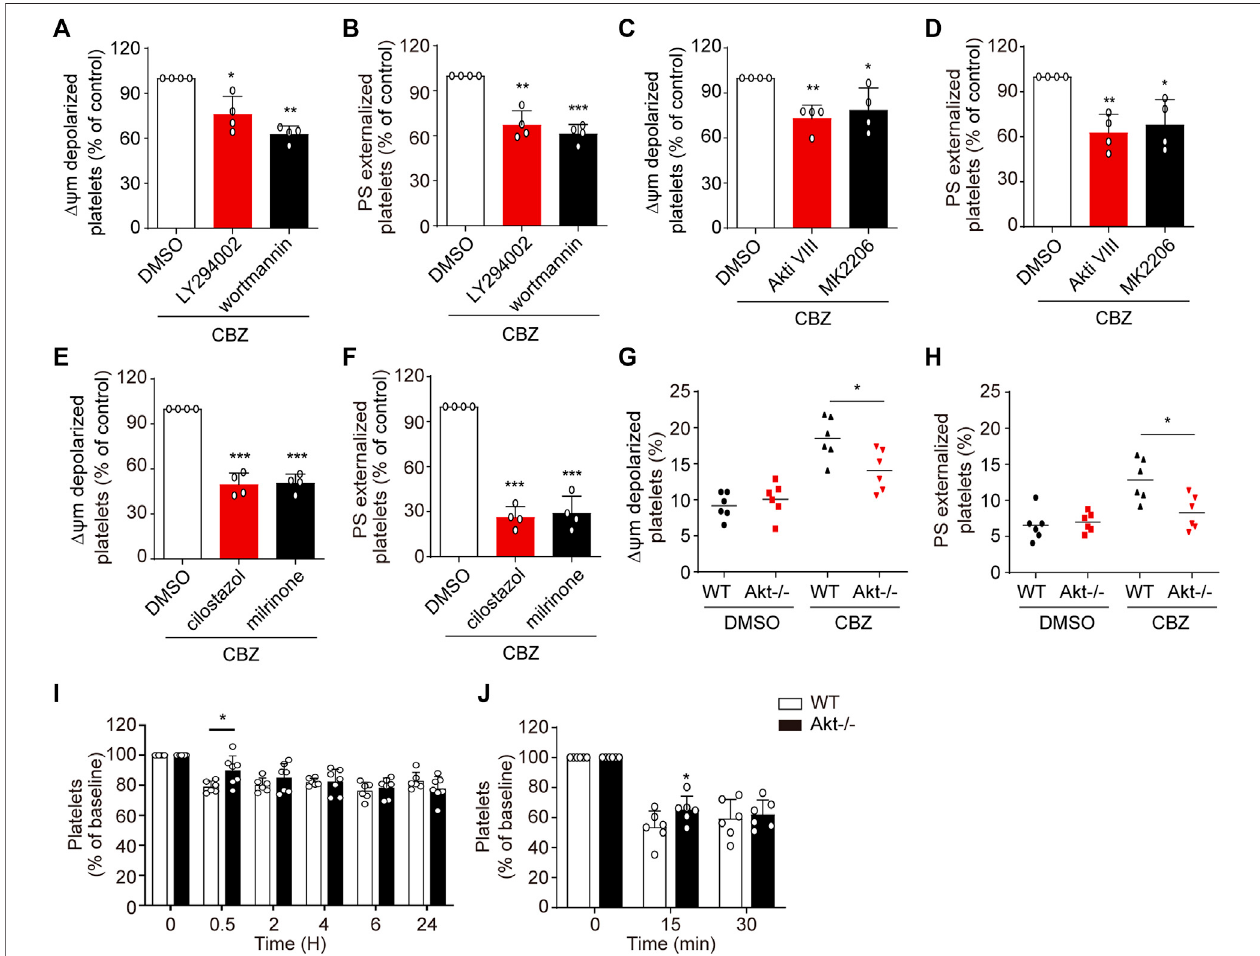
FIGURE 5 | PI3K/Akt/PDE3A inhibition rescues CBZ-treated platelets from apoptosis. (A – F) Washed human platelets were pretreated with indicated concentrations of inhibitors at 37 ° C for 10 min and then incubated with 100 μ M CBZ at 37 ° C for 70 H. (A,B) Flow cytometric analysis of Δψ m depolarization (A) and PS externalization (B) inplateletsinresponsetoPI3Kinhibitors. (C,D) Flowcytometricanalysisof Δψ m depolarization (C) andPSexternalization (D) inplateletsinresponseto Aktinhibitors. (E,F) Flowcytometricanalysisof Δψ m depolarization (E) andPSexternalization (F) inplateletsinresponsetoPDE3Ainhibitors. (A – F) Dataaremean ± SD; n (cid:2) 4;* p < 0.05,** p < 0.01,*** p < 0.001 vs controlgroup,Student ’ s t -test. (G,H) WashedplateletsfromWTor Akt − / − micewereincubatedwith100 μ MCBZat37 ° C for 8 H Δψ m depolarization (G) and PS exposure (H) were analyzed by fl ow cytometry. Horizontal lines indicate the median values, n (cid:2) 6 for each group. * p < 0.05 vs controlgroupbyStudent ’ s t test. (I) WT and Akt − / − micewere i.v. injected withasingle doseofCBZ(1.2 mg/kg)and thenplateletcountswereassessed